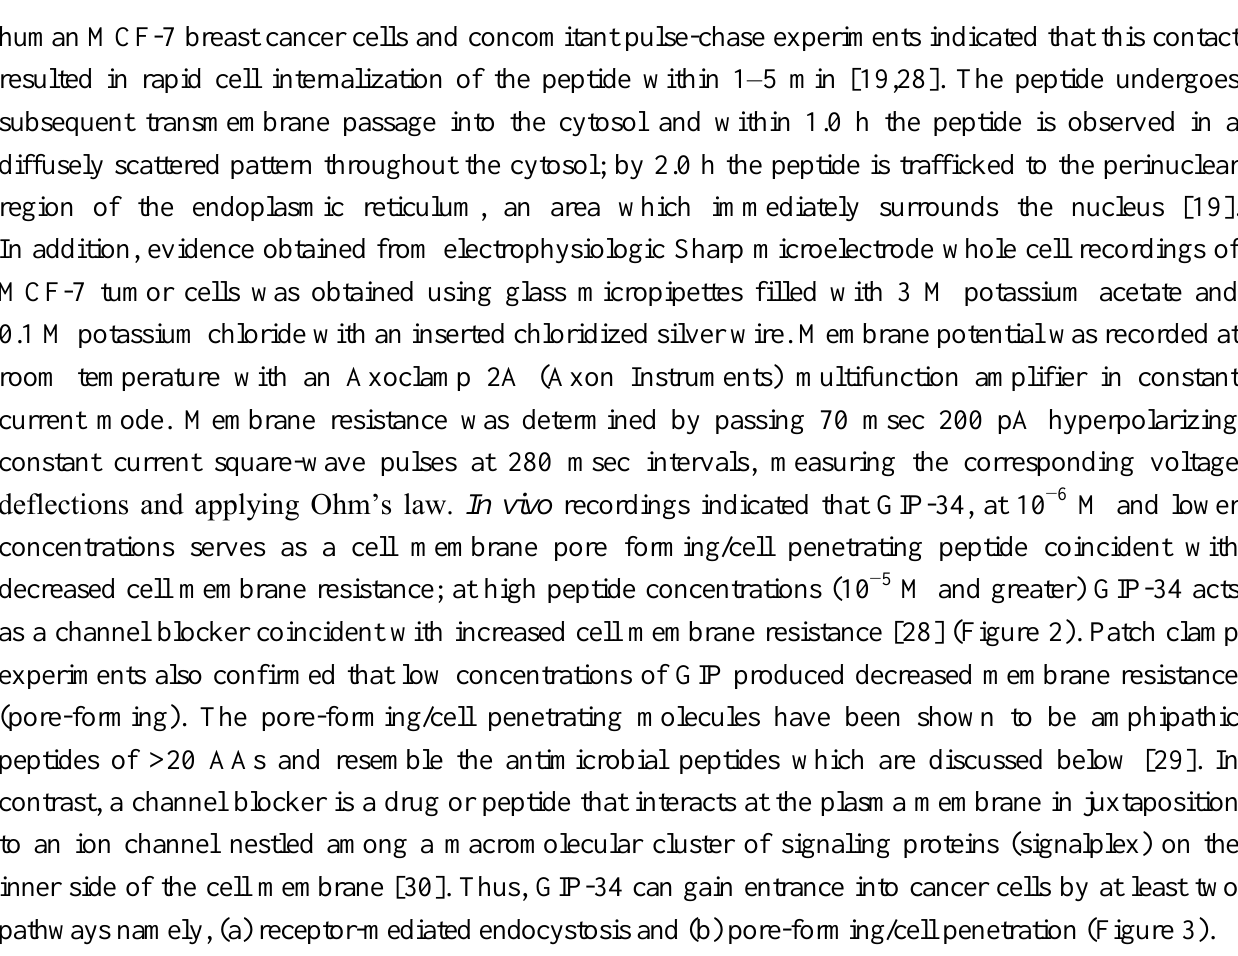
Table 1. Historical background and development of the human alpha-fetoprotein (AFP) derived growth inhibitory peptides 34-mer (GIP-34) and 8-mer (GIP-8); relevance to biological activities (Abbreviations: FMOC = peptide synthesis method; MCF-7,